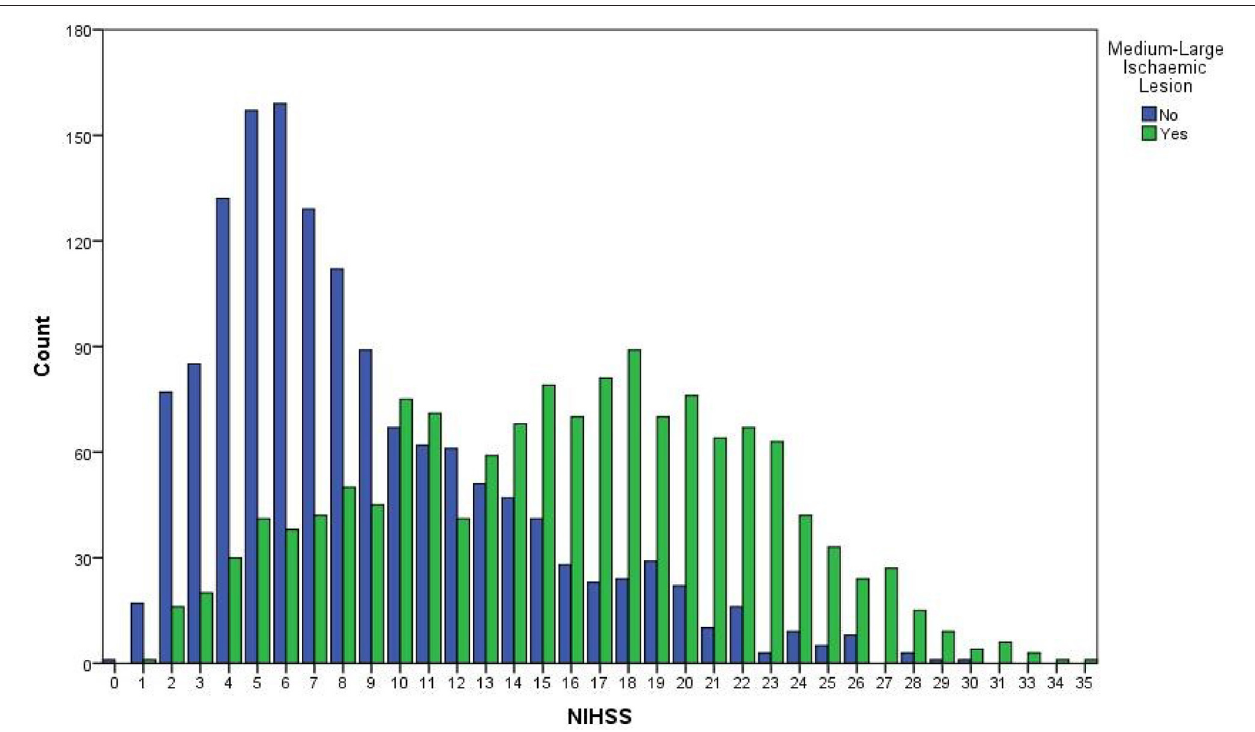
FIGURE 1 | Overlapping histograms for baseline NIHSS among patients with and without a medium-large ischaemic lesion, n = 2,890. NIHSS, National Institutes of Health Stroke